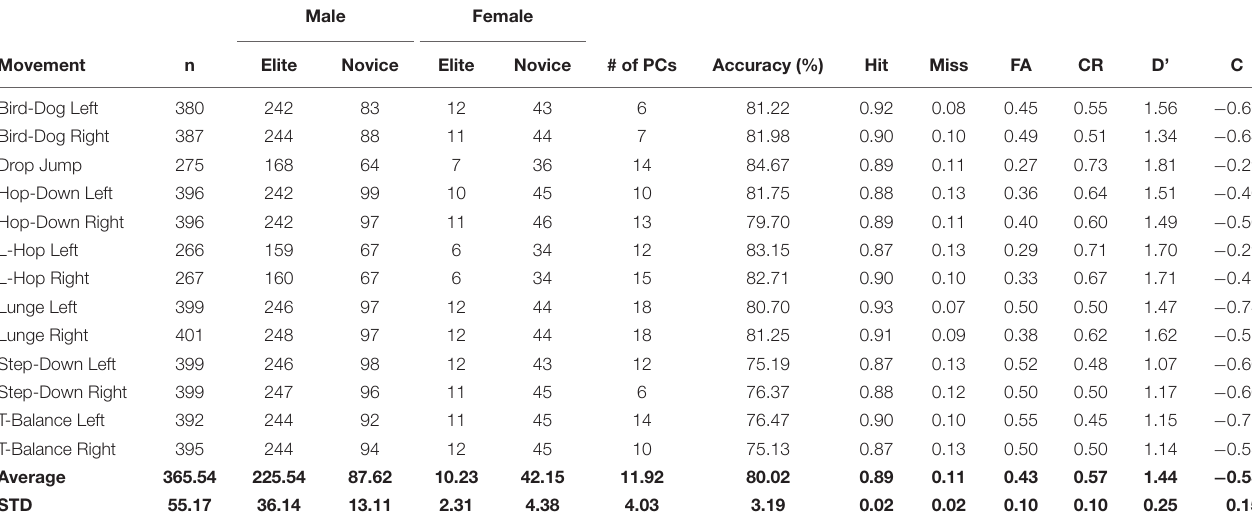
TABLE 2 | OMAT-sIMU: The number of athletes broken down by sex and skill level and overall classification accuracy, hit rate, miss rate, false alarm rate, correct rejection rate, D’ and C when the optimal number of PCs were retained for each movement task. Male Female